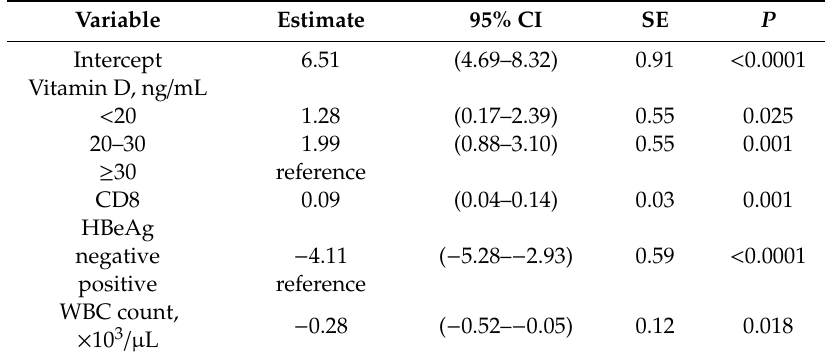
Table 5. Estimates for HBV DNA serum concentration (log10 IU / mL) using multiple linear